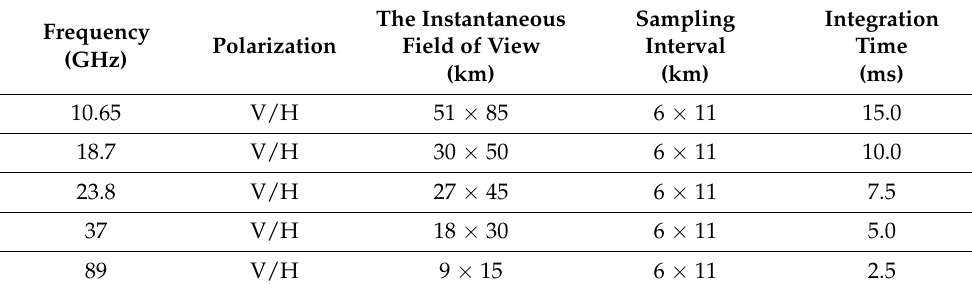
Table 1. Main characteristics of the FY3D